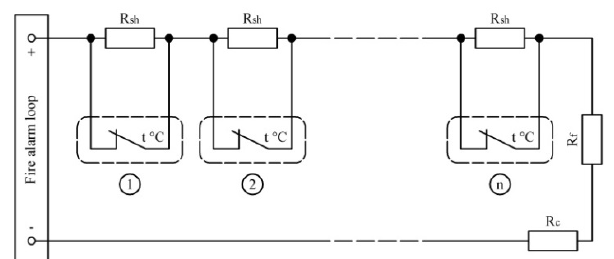
Figure 12. Equivalent electrical circuit of FAL with normally-closed thermal FA R c – permissible linear resistance of the conductor